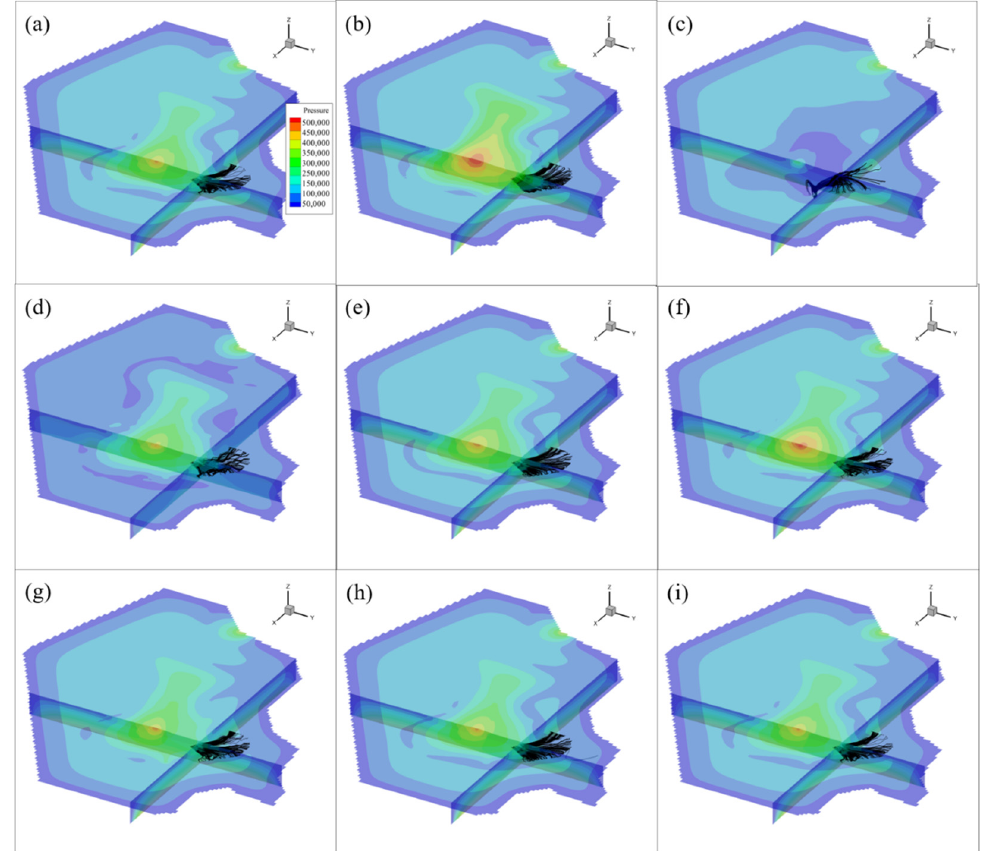
Figure 11. The steady-state flow fields for cases of hydraulic conductivity sensitivity analyses. The selected horizontal planes for the plots are on the repository depth, and two vertical profiles are defined across the center of the repository. ( a ) The base case; ( b ) The hydraulic conductivity of R0 decreases to 5.0 × 10 − 6 m/s; ( c ) The hydraulic conductivity of R0 increases to 1.0 × 10 − 4 m/s; ( d ) The hydraulic conductivity of R# decreases to 1.0 × 10 − 12 m/s; ( e ) The hydraulic conductivity of R# increases to 1.0 × 10 − 9 m/s; ( f ) The hydraulic conductivity of F# decreases to 1.0 × 10 − 8 m/s; ( g ) The hydraulic conductivity of F# increases to 1.0 × 10 − 4 m/s. ( h ) The hydraulic conductivity of EDZ decreases to 3.3 × 10 − 9 m/s; and ( i ) The hydraulic conductivity of EDZ increases to 3.3 × 10 − 7 m/s.